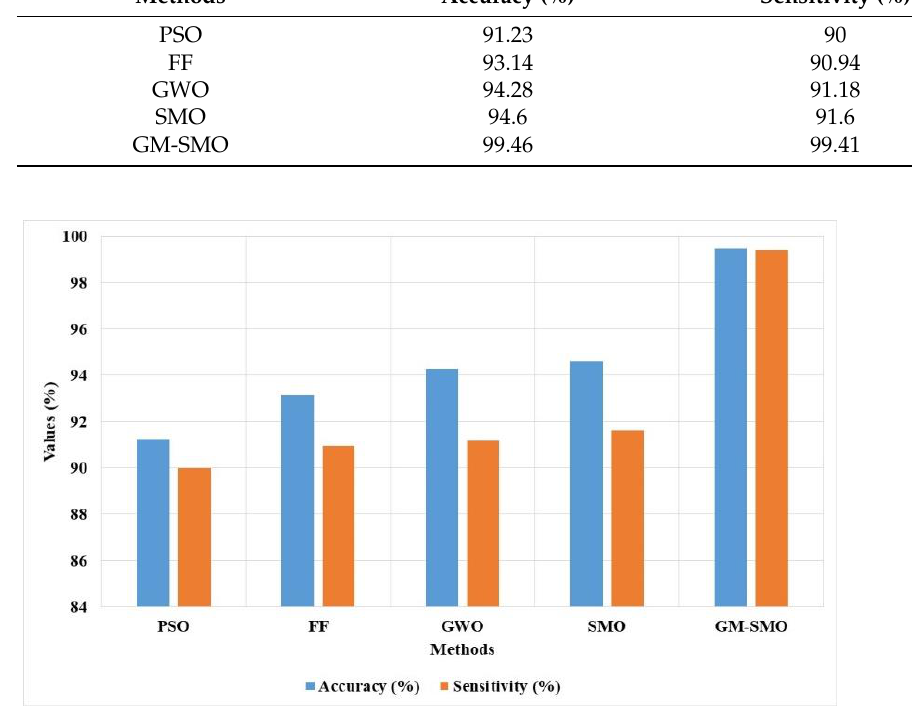
Figure 13. GM-SMO method accuracy and sensitivity compared with existing feature selection techniques.